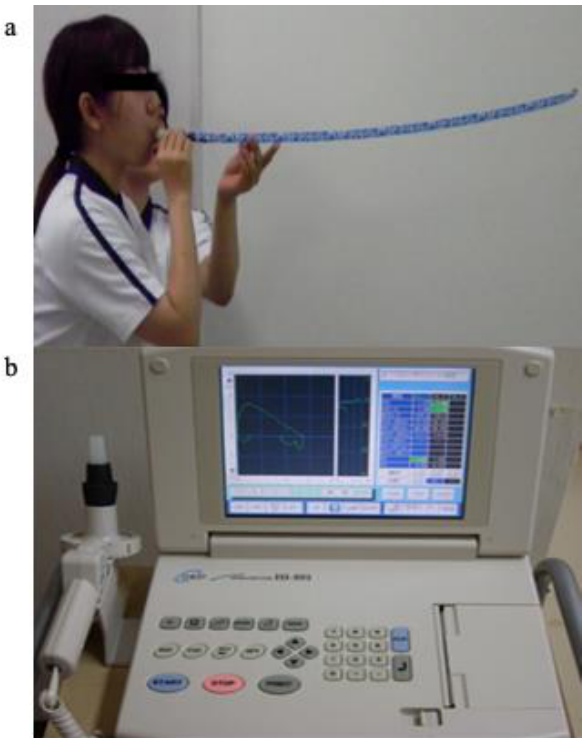
Figure 1. ( a ) Photograph of an individual blowing a 90 cm party horn, and ( b ) HI-801 spirometer (Chest M.I., Tokyo,